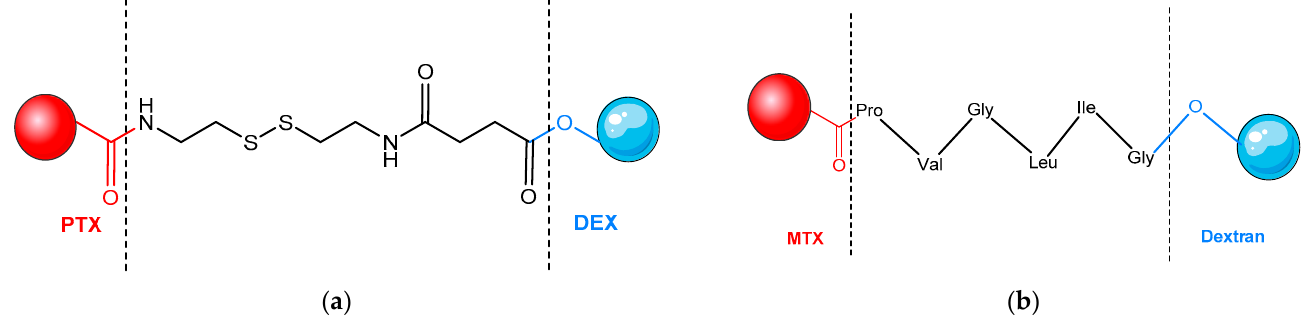
Figure 8. Dextran conjugates: ( a ) DEX–PTX conjugate [151] and ( b ) DEX–MTX conjugate